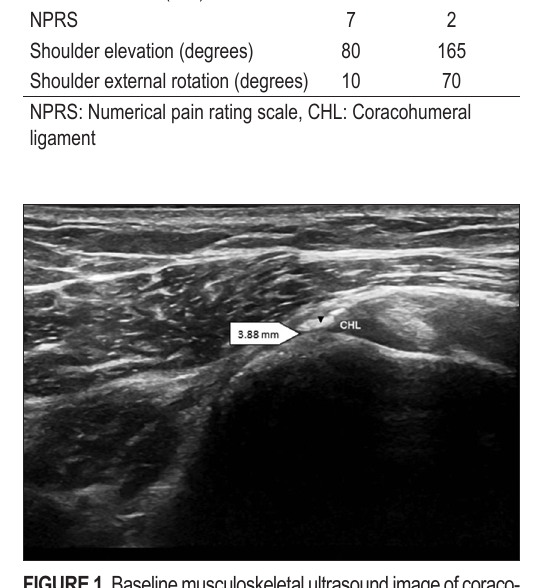
FIGURE 1. Baseline musculoskeletal ultrasound image of coraco- humeral ligament calcification size.